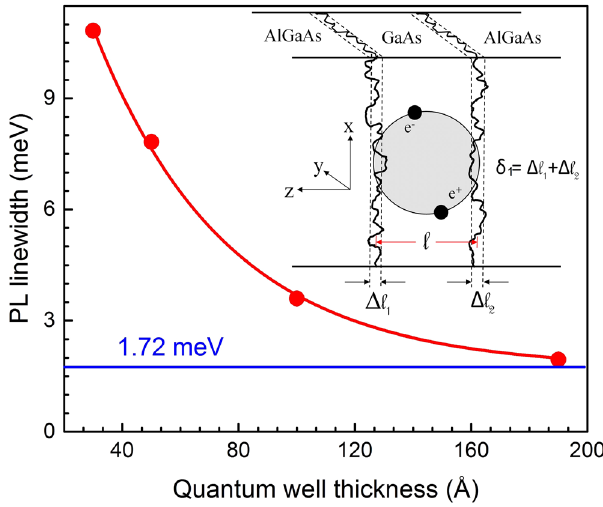
Figure 6. Variation of PL linewidth ( P 1 ) with QW thickness is shown. The minimum PL linewidth of AlGaAs/ GaAs QWs is estimated to be (1.72 ± 0.05) meV. Inset of the figure shows, atomic irregularities at the hetero- interface resulting local variation in QW width. Excitons in narrow QWs substantially experience atomic irregularities at the hetero-junction, and undergo strong influence due to barrier layer.